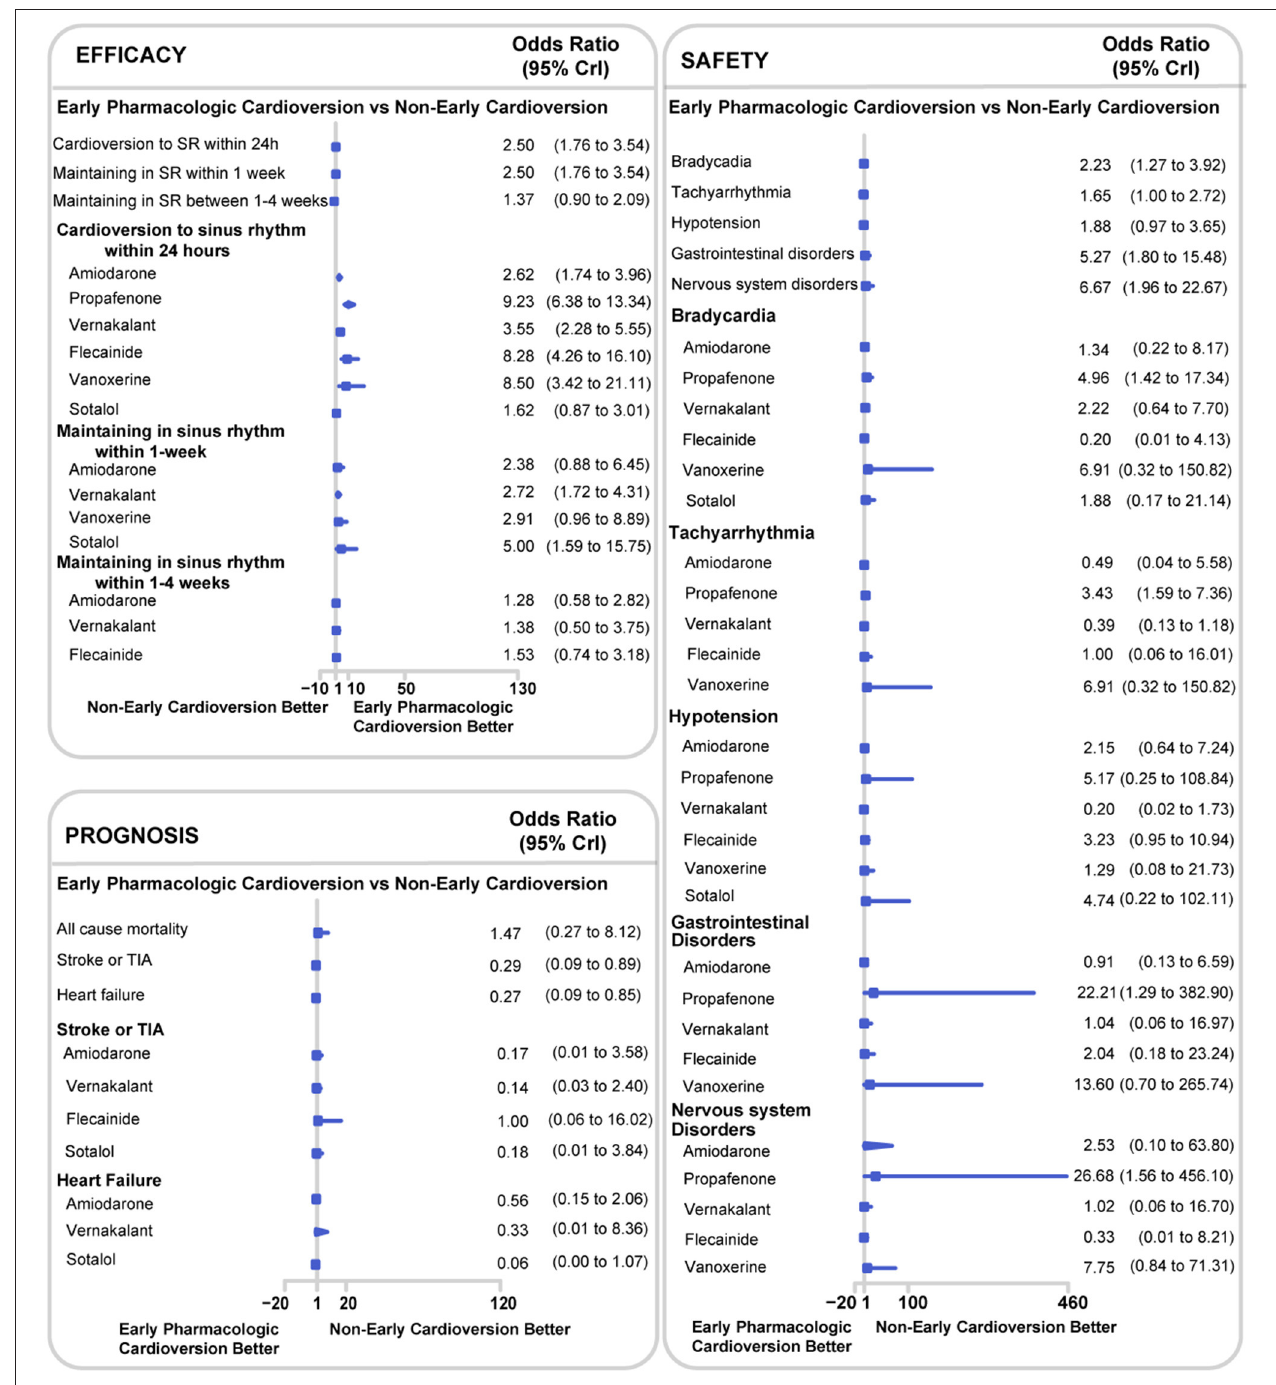
FIGURE 3 | Network meta-analysis results for all endpoints between early pharmacologic cardioversion and non-early cardioversion. The forest plot was based on the Bayesian framework. The antiarrhythmic drugs as early pharmacologic cardioversion in the study included amiodarone, propafenone, flecainide, tedisamil, vernakalant, vanoxerine, and sotalol. All endpoints are efficacy endpoints including cardioversion to sinus rhythm within 24h, maintenance in sinus rhythm within 1-week and maintenance in sinus rhythm within 1–4-weeks, safety endpoints including bradycardia, tachyarrhythmia, hypotension, gastrointestinal disorders, and nervous system disorders, and prognostic endpoints including all-cause mortality, stroke or TIA and heart failure. CrI, Credible Interval; TIA, Transient Ischemic Attack. of stroke or TIA, and 3 studies with 366 participants reported the rate of heart failure ( Figure 2